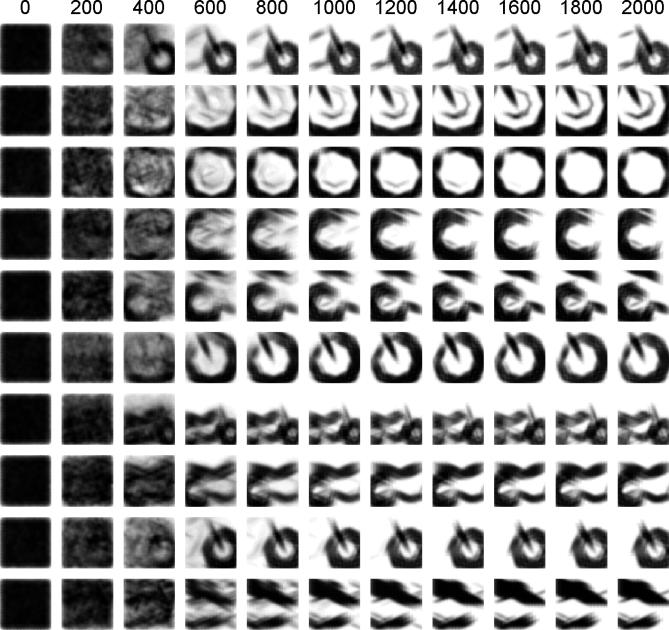
Evolution of Reconstructions for Motorbike Features